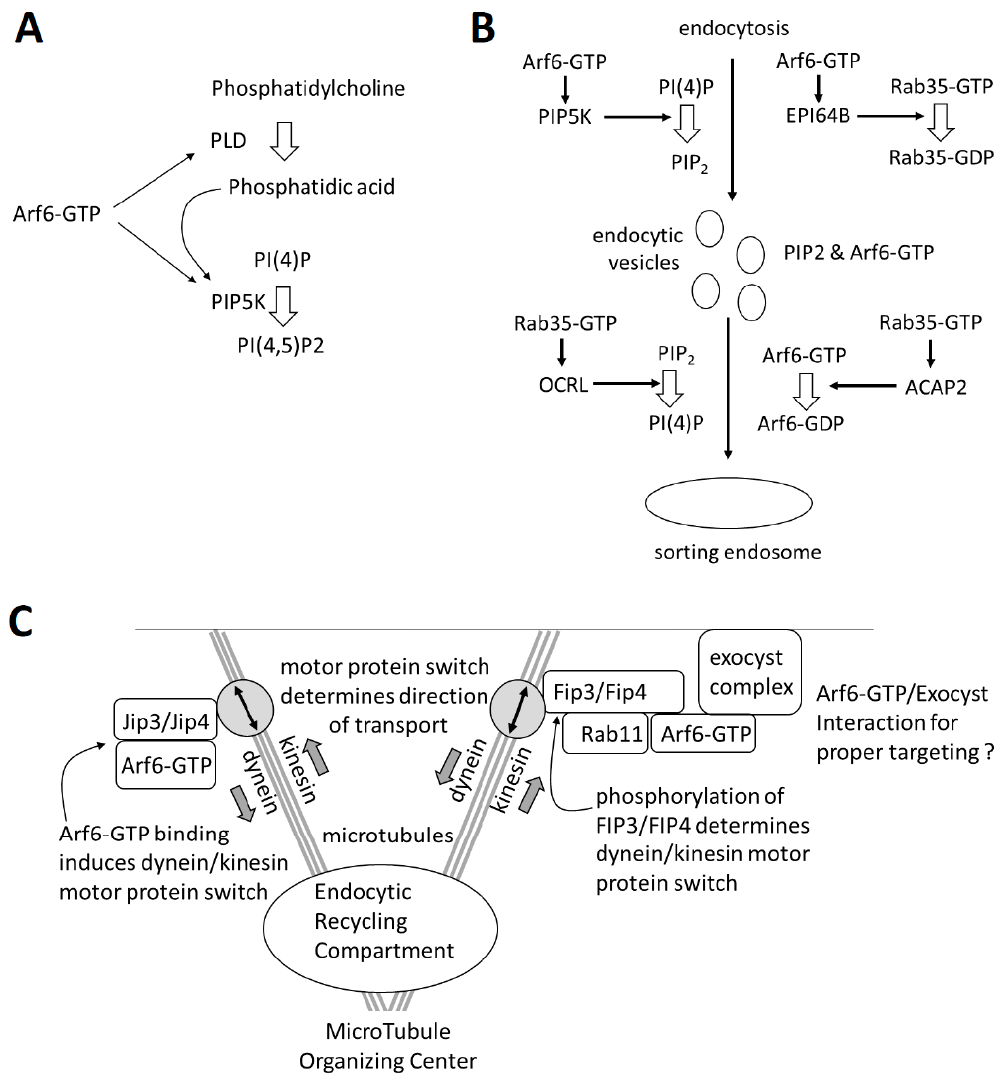
Figure 2. A schematic overview of some of the major effectors of Arf6: ( A ) Arf6 activates phosphatidylinositol 4-phosphate 5-kinase (PIP5K) and phospholipase D (PLD). ( B ) The antagonism between Arf6 and Rab35 is shown here in the context of early steps of vesicular transport after endocytosis. ( C ) The Arf6 interaction with adapter proteins Jip3/4, Fip3/4, and the exocyst.